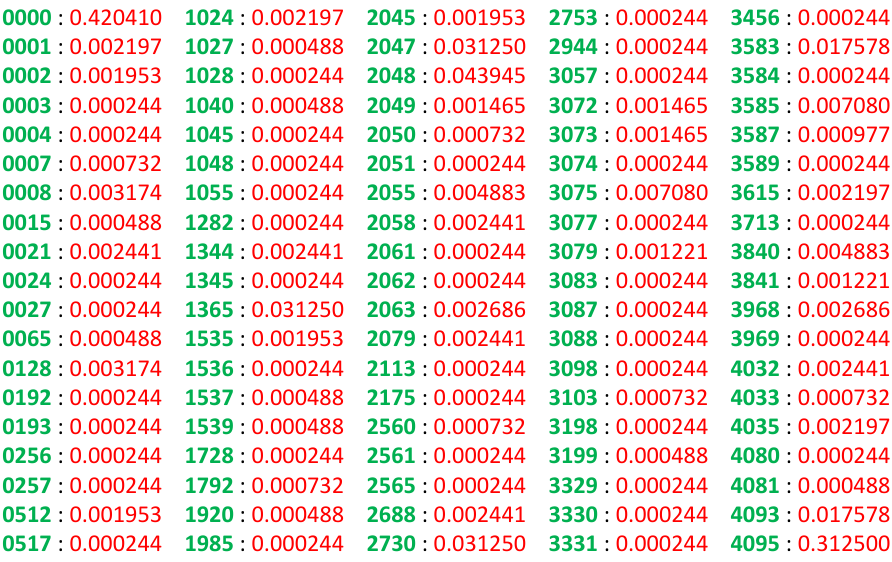
Figure 6. QPULBA( m , n , d , t , c ) algorithmic probability (in red) for Case m = 2, n = 2, d = 1, t = 12, c = 12 (for non-zero